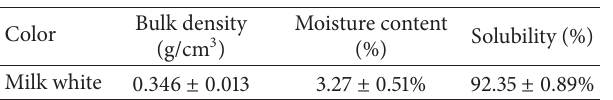
(C 15 H 10 O 6 ), quercetin 7, 4 󸀠 -diglucoside (C 27 H 30 O 17 ), and Table 4: Color, bulk density, moisture content, and solubility of